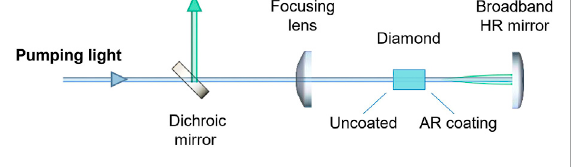
FIGURE 2 Schematic of the hemi-spherical diamond Raman cavity simulated in the Stokes generation mathematical tool, where all the elements depicted and the spacing between them are variable and considered in the simulator.